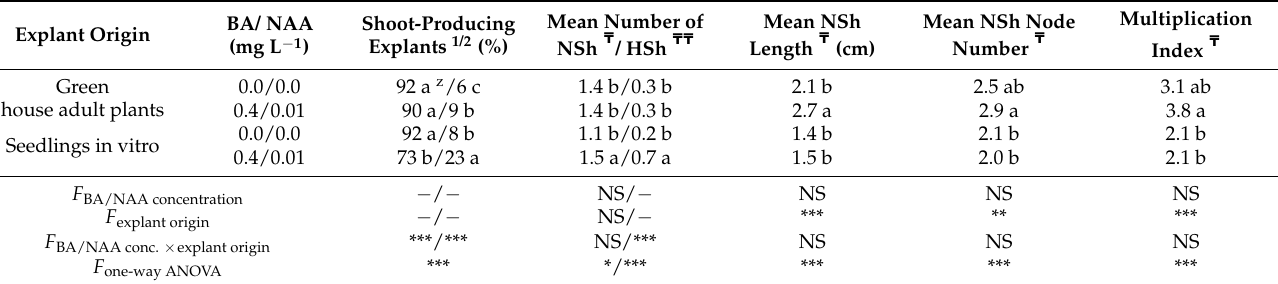
z Mean separation in columns by Student’s t , p ≤ 0.05; means followed by the same letter are not significantly different at p ≤ 0.05. NS: nonsignificant or **, *** significant at p ≤ 0.01, p ≤ 0.001, respec- tively, n = 7–14. Multiplication index = shoot-producing explants 1 (%) × mean shoot number ₸ × mean node number ₸ . 1 The explants produced normal and hyperhydrated shoots. 2 The explants produced hyperhydrated shoots only. ₸ NSh = normal shoot. ₸₸ HSh = hyperhydrated shoot.